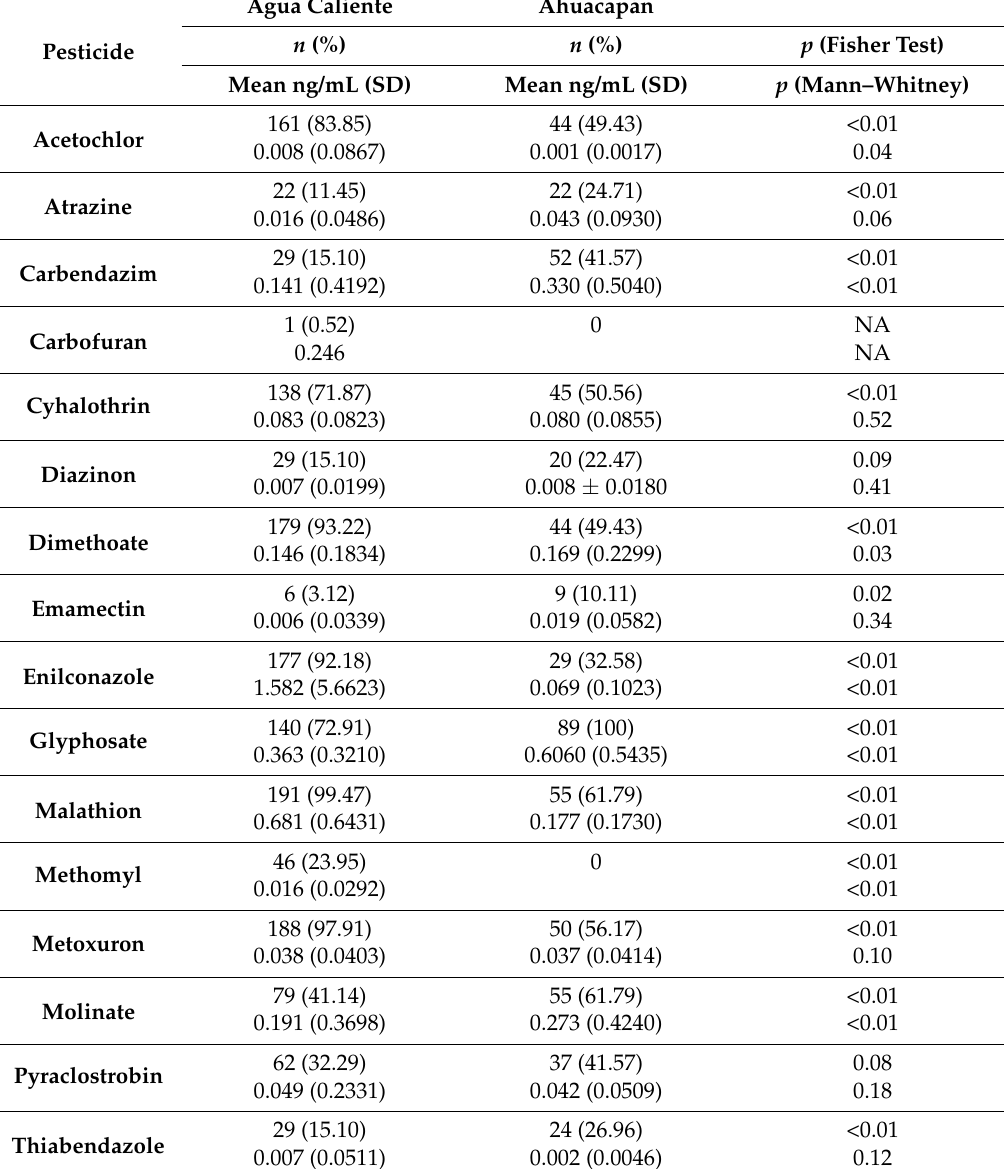
Table 4. Frequencies, percentages, means, and standard deviations (SD) of pesticides in urine. Agua Pesticide